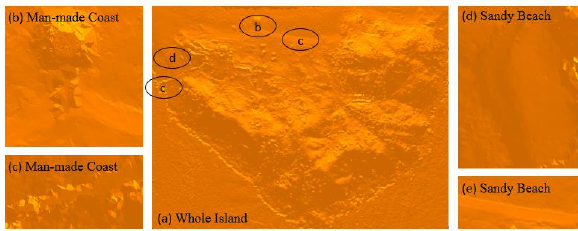
Figure 8: Ground surface of Wuzhizhou Island: (a) whole island ground surface. (b) Enlarged view of a man-made coast (position b). (c) Enlarged view of a Man-made coast (position c). (d) Enlarged view of sandy beach (position d). (e) Enlarged view of sandy beach (position